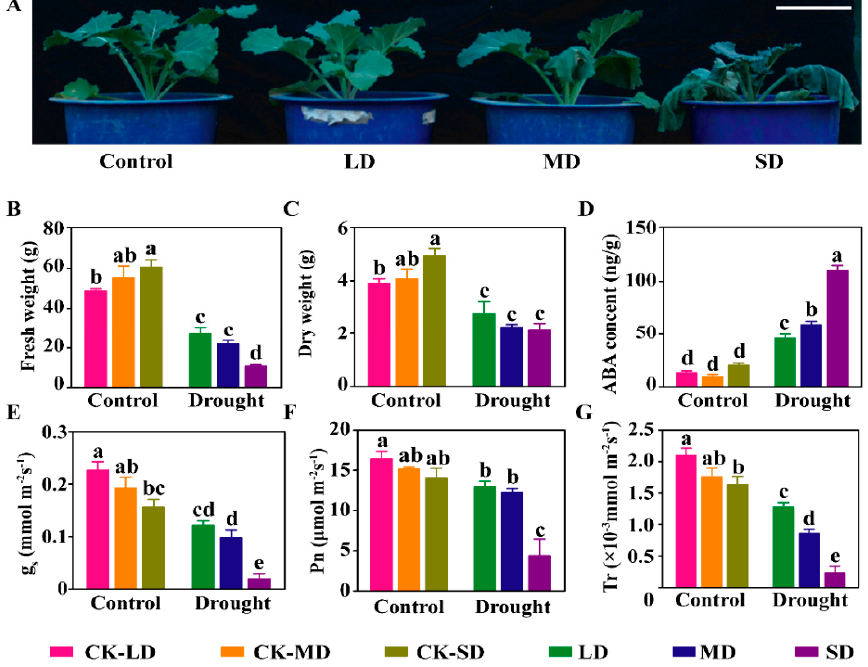
Figure 1. Characterization of physio-biochemical traits responding to varying degrees of drought stress. ( A ) The response of B. napus to varying degrees of drought stress. Bar = 10 cm. ( B ) Aboveground fresh weight under varying degrees of drought stress. ( C ) Aboveground dry weight under varying degrees of drought stress. The data are the means ± standard deviation ( n = 4). ( D – G ) Abscisic acid content ( D ), stomatal conductance ( E ), net photosynthetic rate ( F ), transpiration rate ( G ) under varying degrees of drought stress. LD, mild drought stress; MD, moderate drought stress; SD, severe drought stress; CK-LD, CK-MD, and CK-SD, the respective controls of LD, MD and SD. The data are the means ± standard deviation ( n = 4). Different lowercase letters indicate significant differences, while the same letters indicate no significant difference (one–way ANOVA for multiple comparisons, p < 0.05).